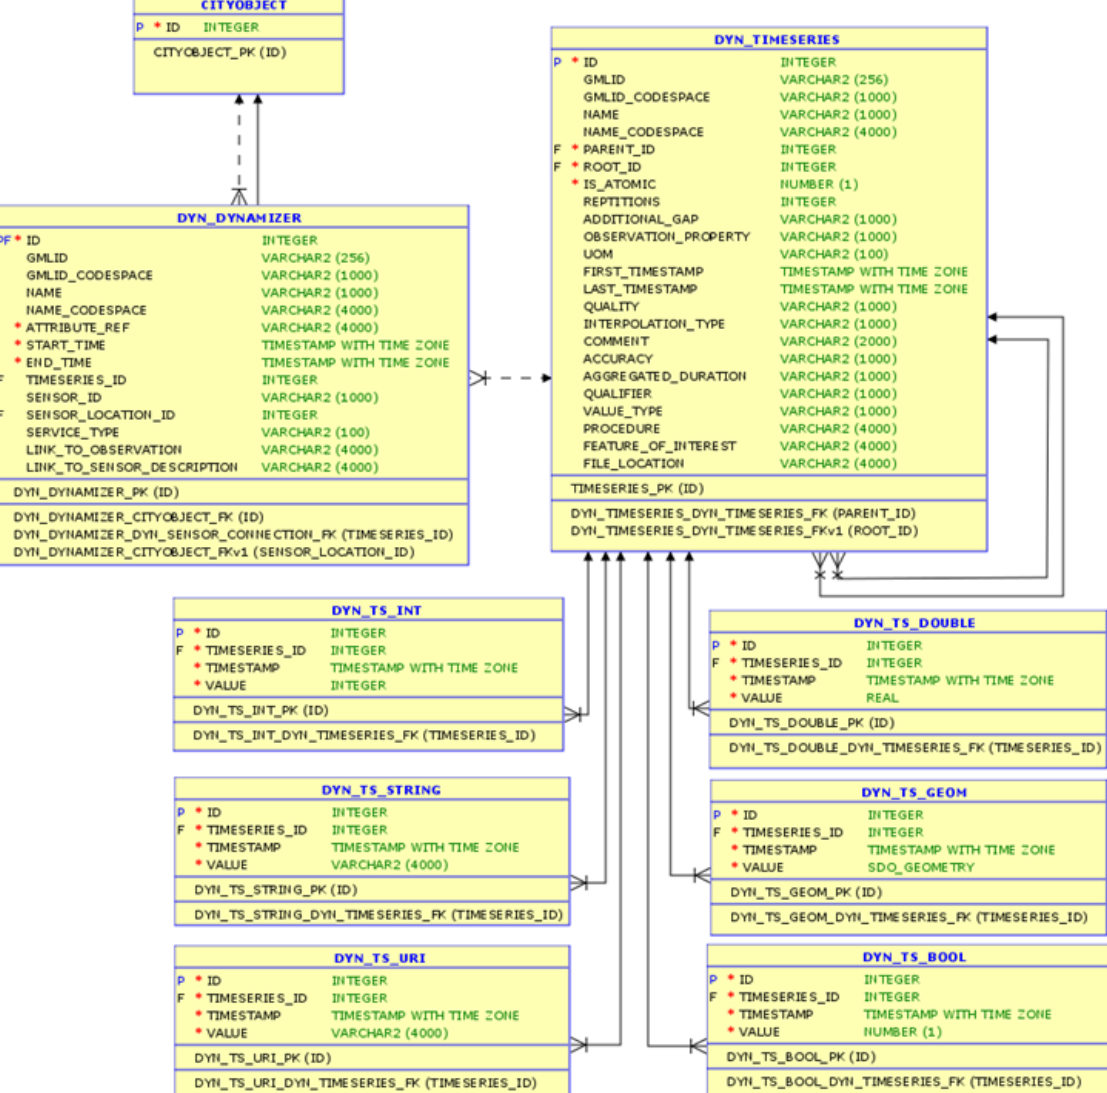
Figure 3. Relational Database Model of Dynamizer ADE. The figure shows individual tables of Dynamizer along with their columns and primary and foreign